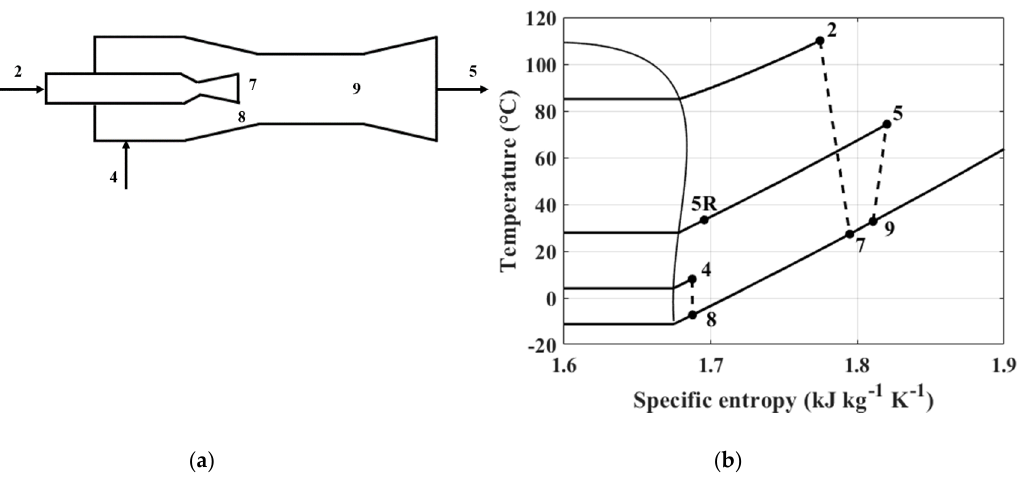
Figure 2. ( a ) Schematic ejector representation. ( b ) Ejector working processes on the T-s diagram.